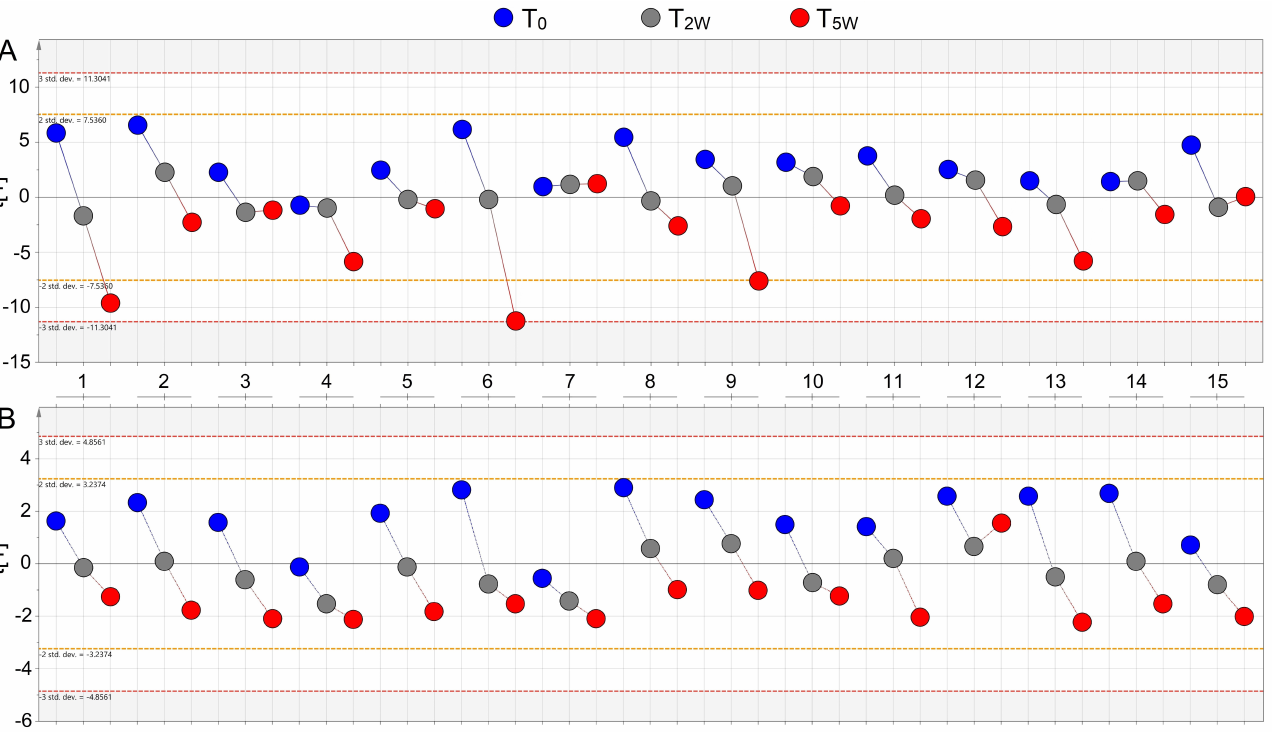
Figure 6. Comparison between metabolomic and distance patterns of 15 representative COPD patients during the whole T 0 –T 2W –T 5W PR cycle. ( A ) Metabolomic path from the OPLS-DA model obtained with NMR parameters. ( B ) Walk path from the OPLS model considering the walked distances as y-variables. The numbers on the x -axis between the panels label the COPD